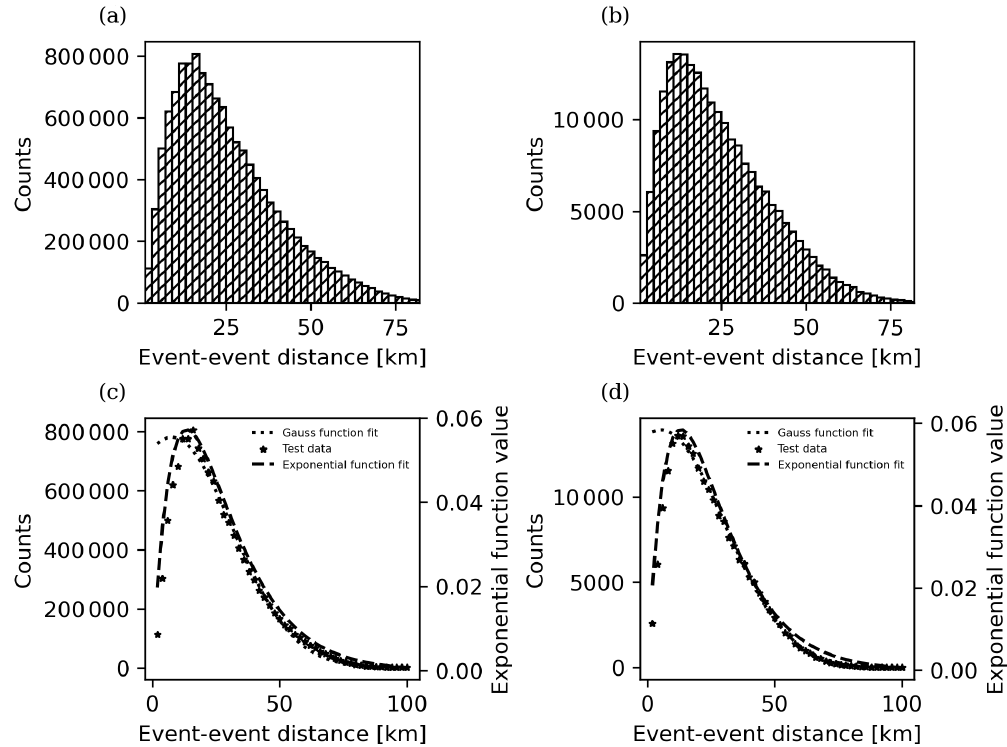
Figure 13. (a) Event-event distance distribution for events from 2000 to 2016. (b) Functions fit for the event-event distance distribution for events from 2000 to 2016. (c) Event-event distance distribution for the events from 2016 to 2018. (d) Functions fit for the event-event distance distribution for events from 2016 to 2018. Table 3. Parameters obtained by fitting the Gaussian and exponential function to the counts in the event-event distance distribution for the Vrancea region catalog. Last column shows the R 2 of the